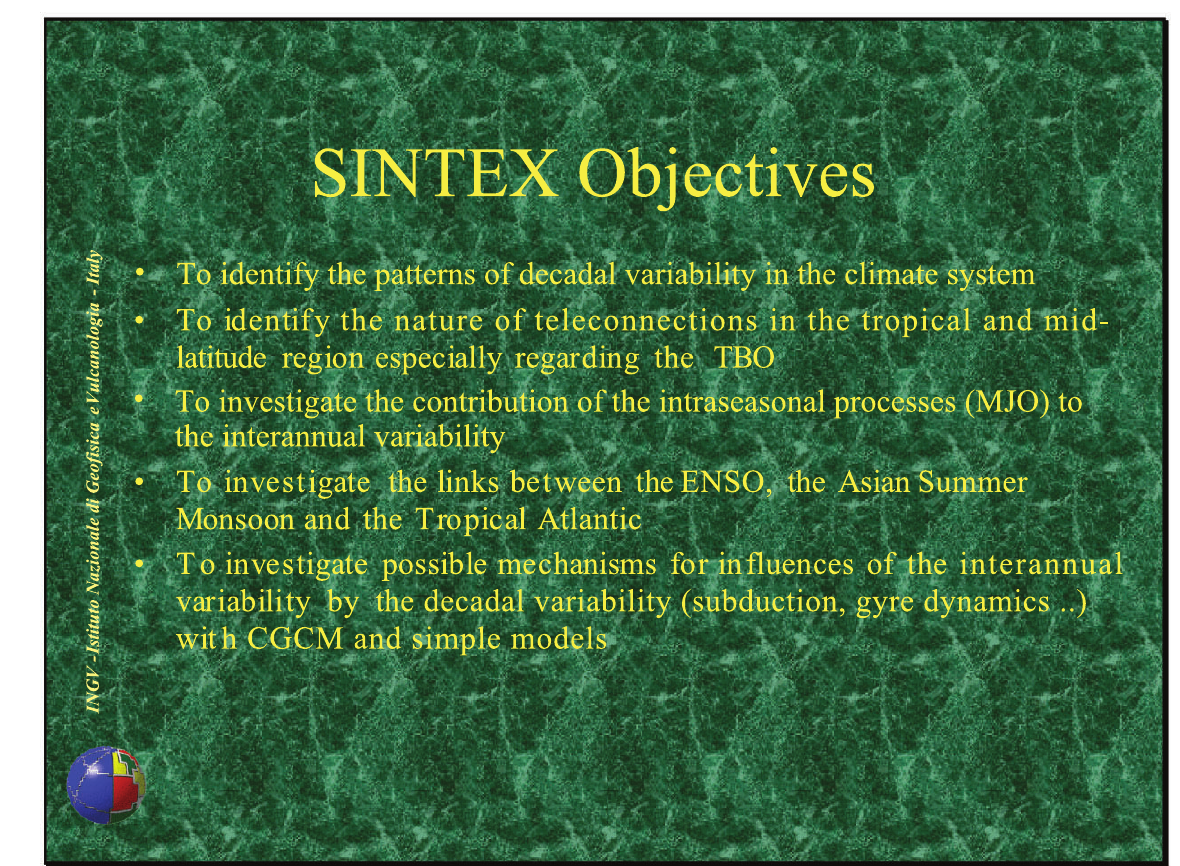
Fig. 3. The original slide of the SINTEX objectives